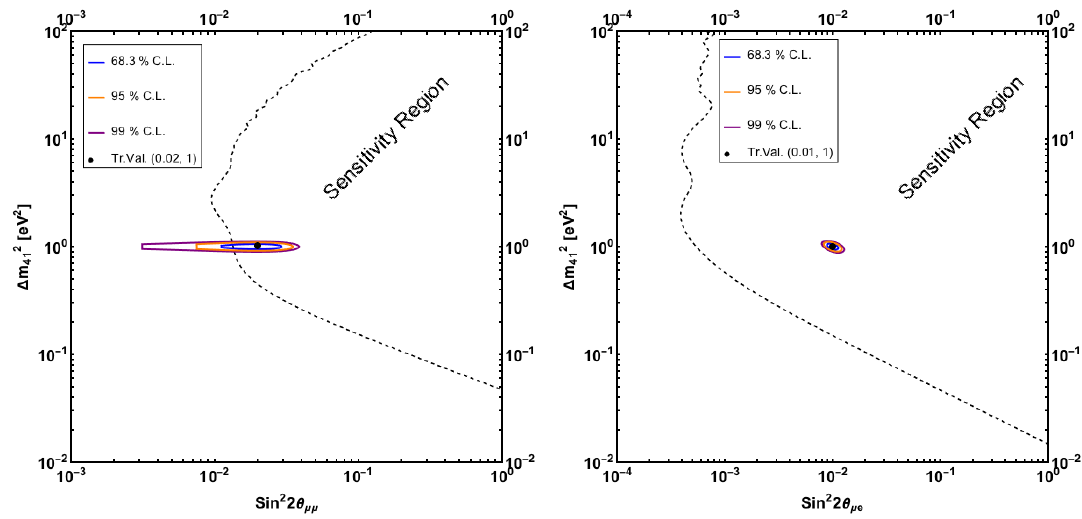
Figure 5 . Left (Right) panel: allowed Regions considering the ‘true’ neutrino event spectrum given by the 3 + 1 model with the values sin 2 2 (cid:18) (cid:22)(cid:22) = 0 : 02 and (cid:1) m 2 and (cid:1) m 2 = 1 eV 2 ) in the muon neutrino disappearance channel (the electron neutrino appearance 41 channel). The dashed curve in both plots is the sensitivity curve for the respective